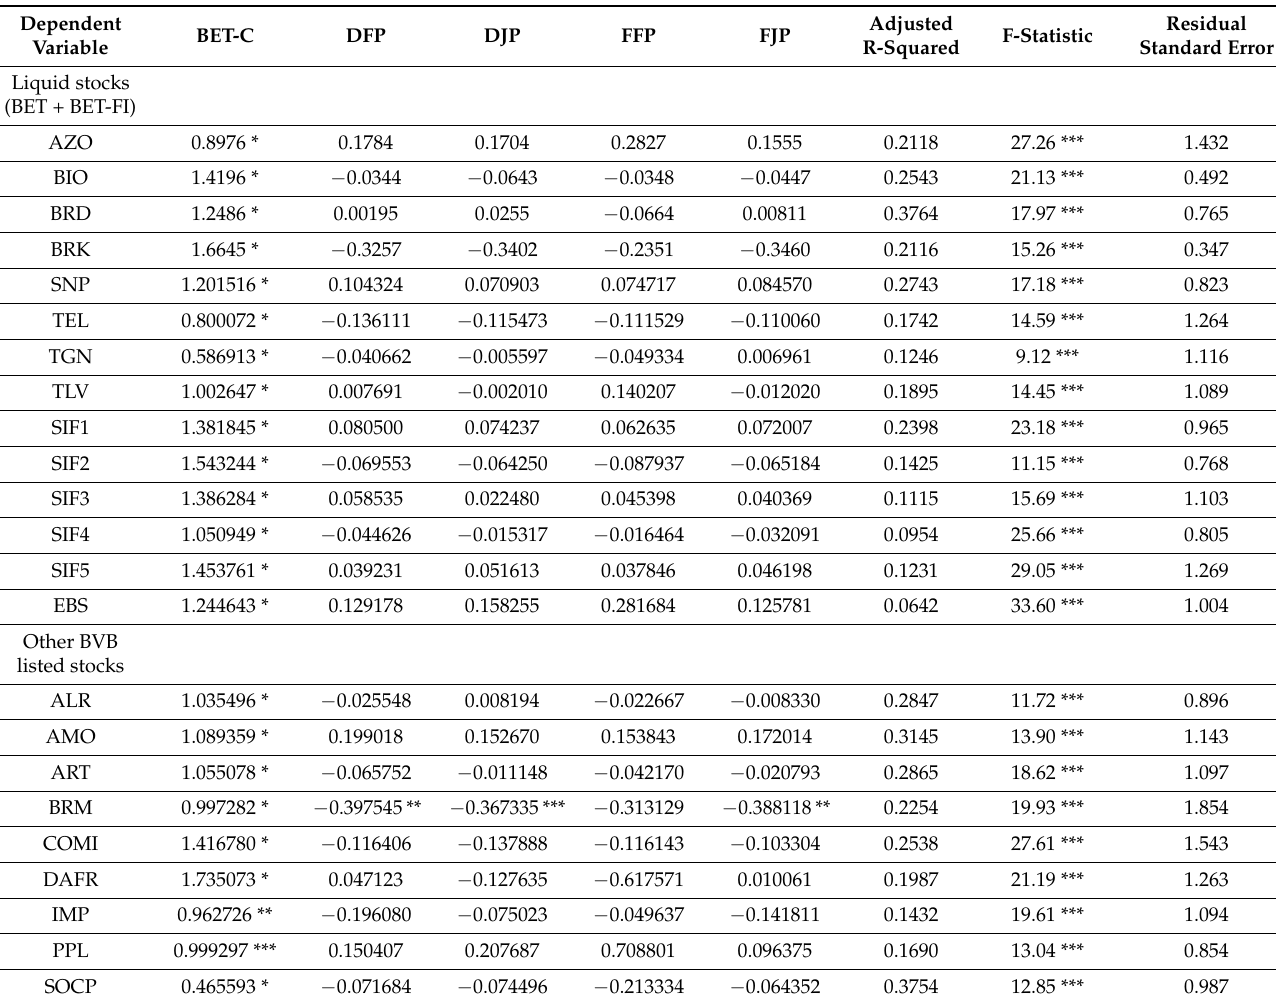
Table 4. Contemporaneous relationships between stock returns and investors trading